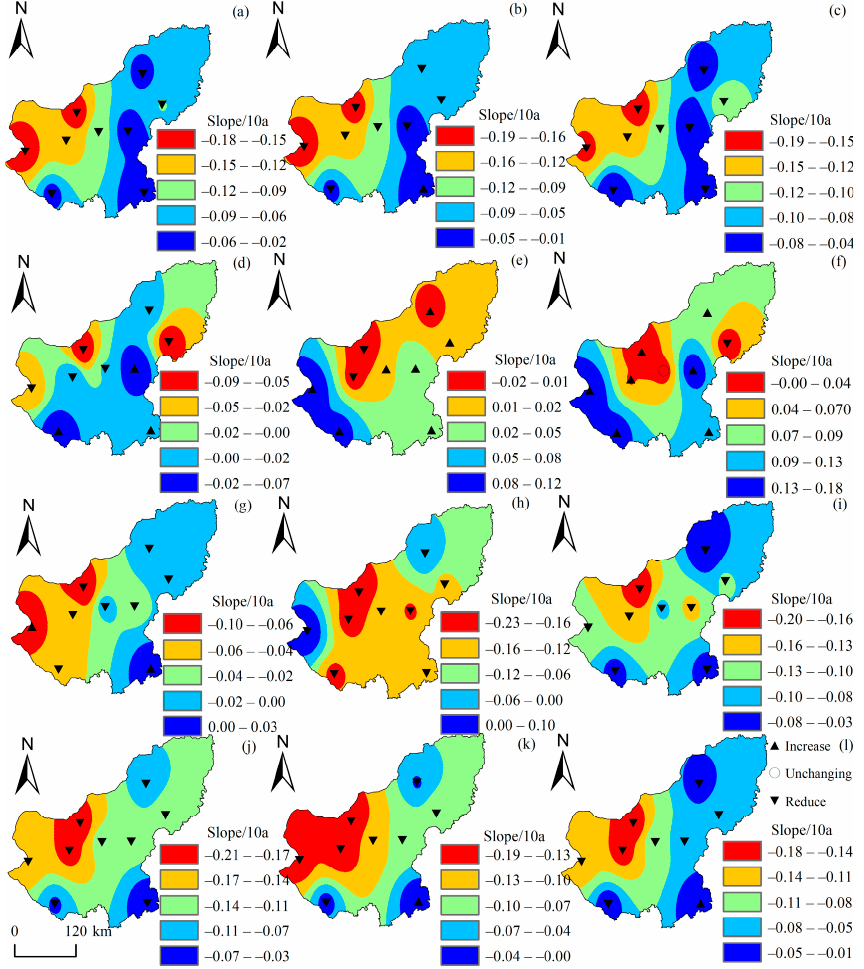
Figure 5. Drought trend variation of stations from 1969 to 2018. ( a ) January, ( b ) February, ( c ) March, ( d ) April, ( e ) May, ( f ) June, ( g ) July, ( h ) August, ( i ) September, ( j ) October, ( k ) November, and ( l ) December.